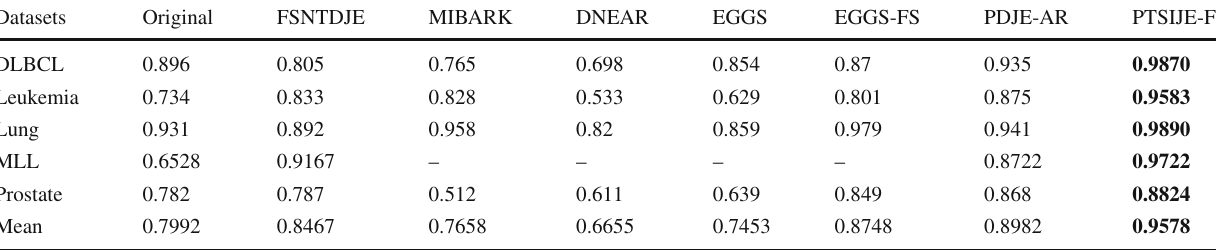
Table 9 Classification accuracy of the seven methods under the KNN classifier Datasets